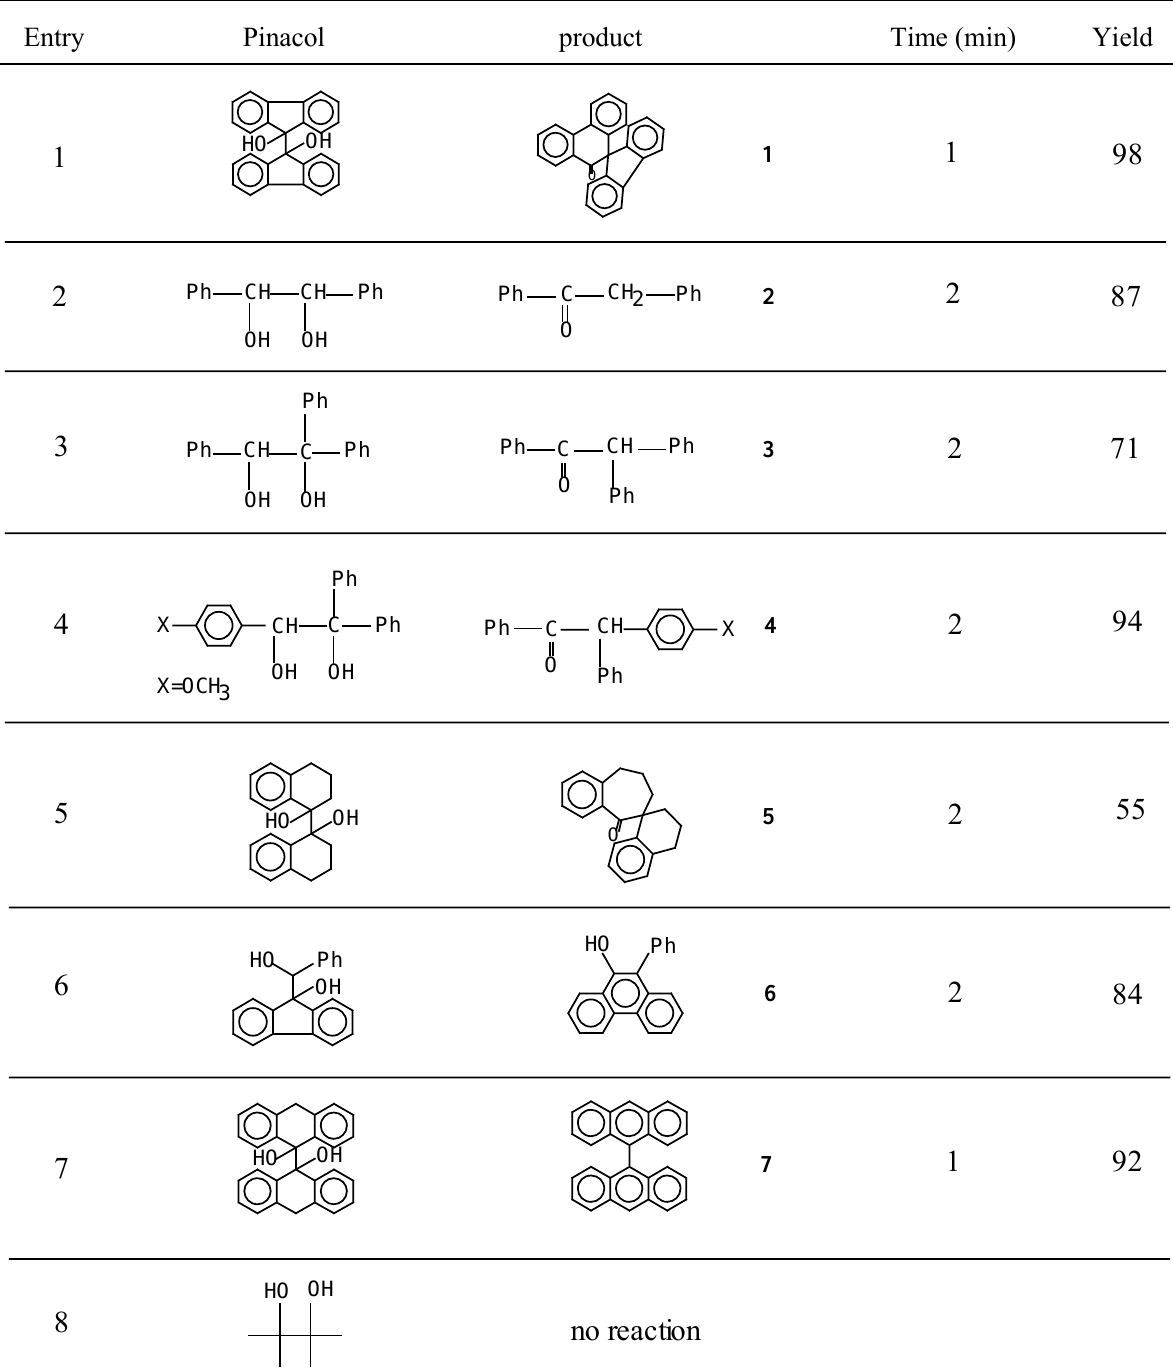
Table 1 . Rearrangements of pinacols to the corresponding products. All the reactions were carried out at room